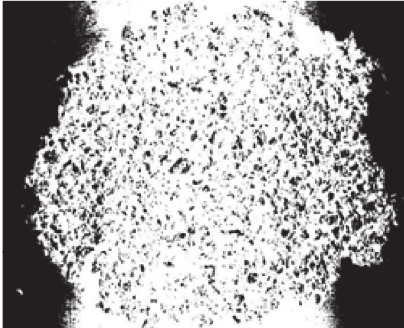
Figure 2: Original picture of camera obscura. This image is taken as an example to show the effect of each operation of boundary extraction.